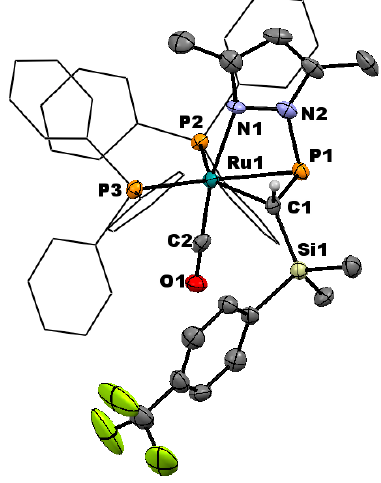
Figure 2. Molecular structure of [Ru{ η 1 - N : η 2 - P,C -P(pz Me2 )=CH(SiMe 2 C 6 H 4 CF 3 - p )}(CO)(PPh 3 ) 2 ] ( 3d ) in crystals of the chloroform solvate, with thermal ellipsoids at the 50% probability level. Ancillary phenyl rings are reduced, and hydrogen atoms omitted for clarity. Selected bond distance (Å) and angles (°): Ru–P1 2.381(1), Ru–P2 2.359(1), Ru–P3 2.369(1), Ru–C1 2.211(4), Ru–C2 1.831(5), Ru–N1